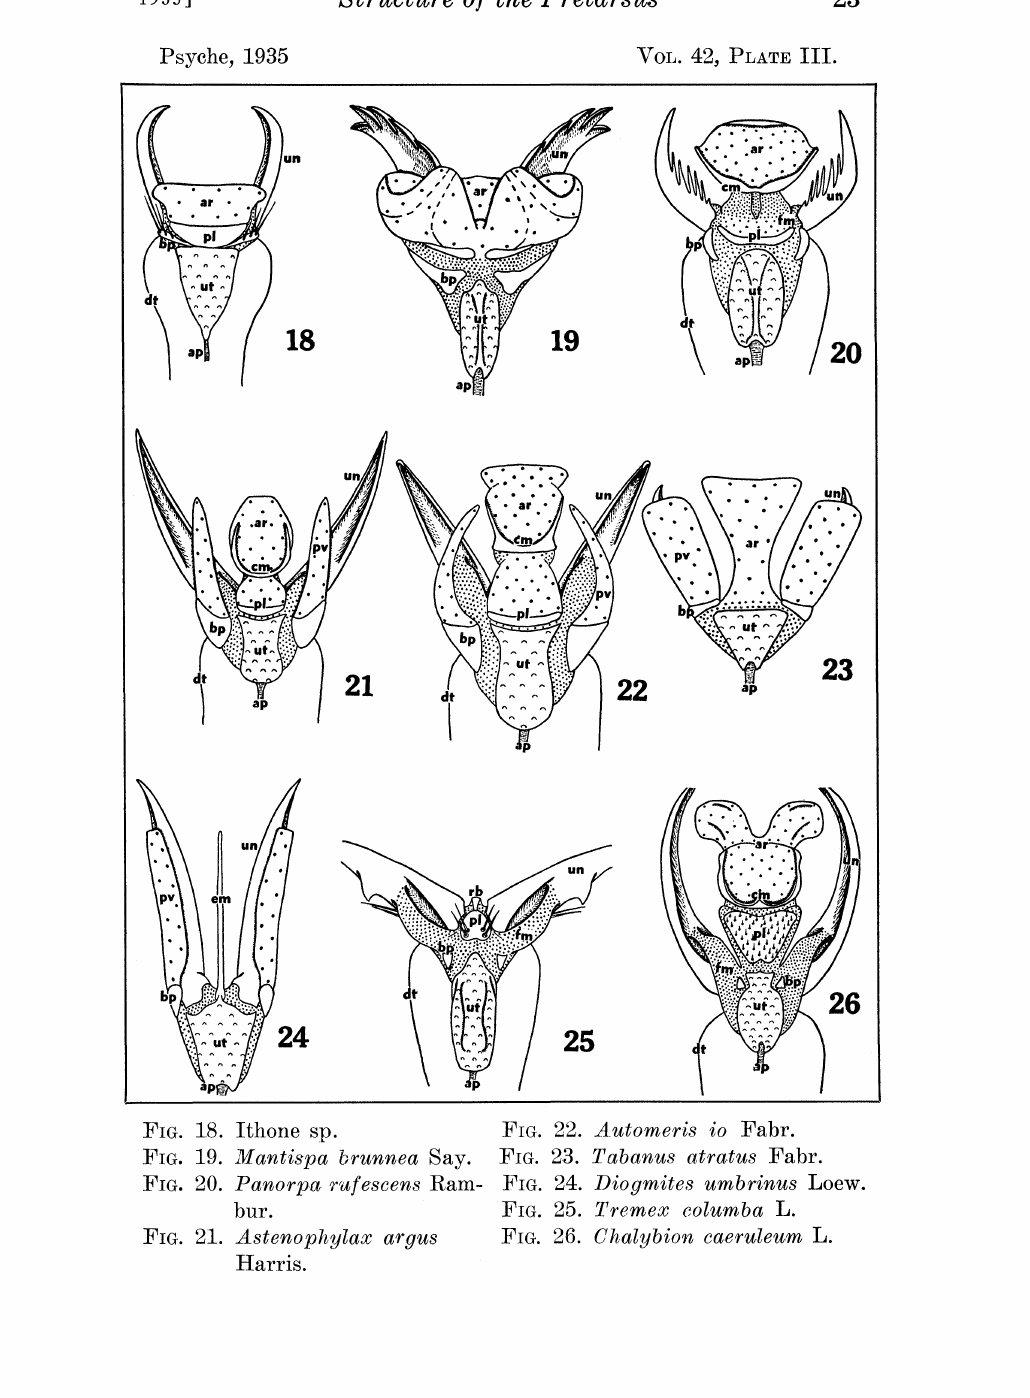
FIG. 22. Automeris io Fabr. FIG. 23. Tabanus atratus Fabr. FIG. 25. Tremex columba L. F_G. 26. Chalybion caeruleum